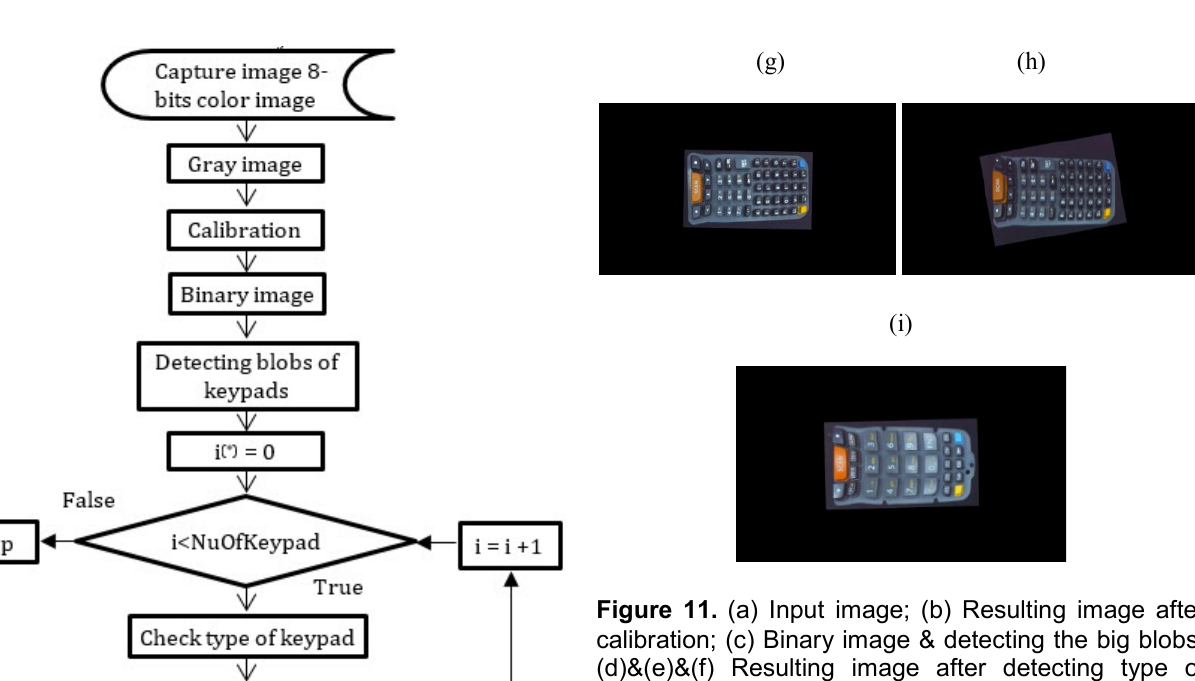
Figure 10. Flowchart of the automatic defect detection. (*): i counts order of image.